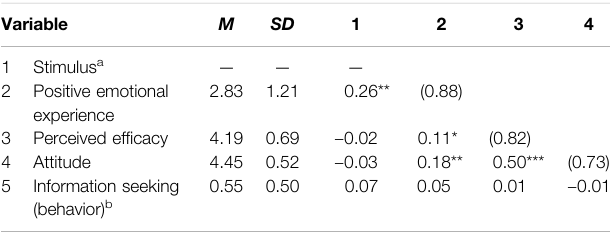
TABLE 2 | Study 2: means, standard deviations, Pearson zero-order correlations, and internal consistencies/correlations. Variable